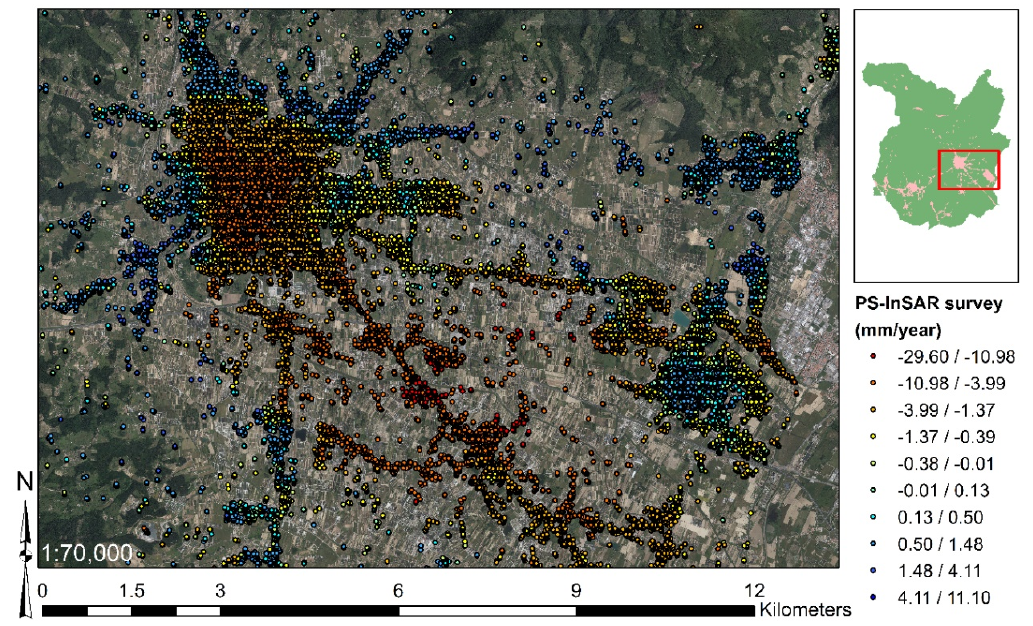
Figure 5. Surface motion map over the city center of Pistoia.